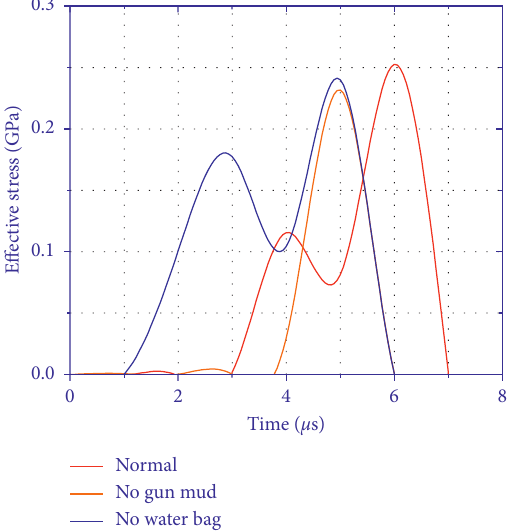
Figure 16: Stress curves of nonshot mud-charge blasting